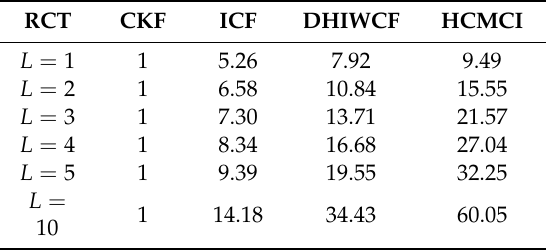
Table 2. The relative computational time for di ff erent